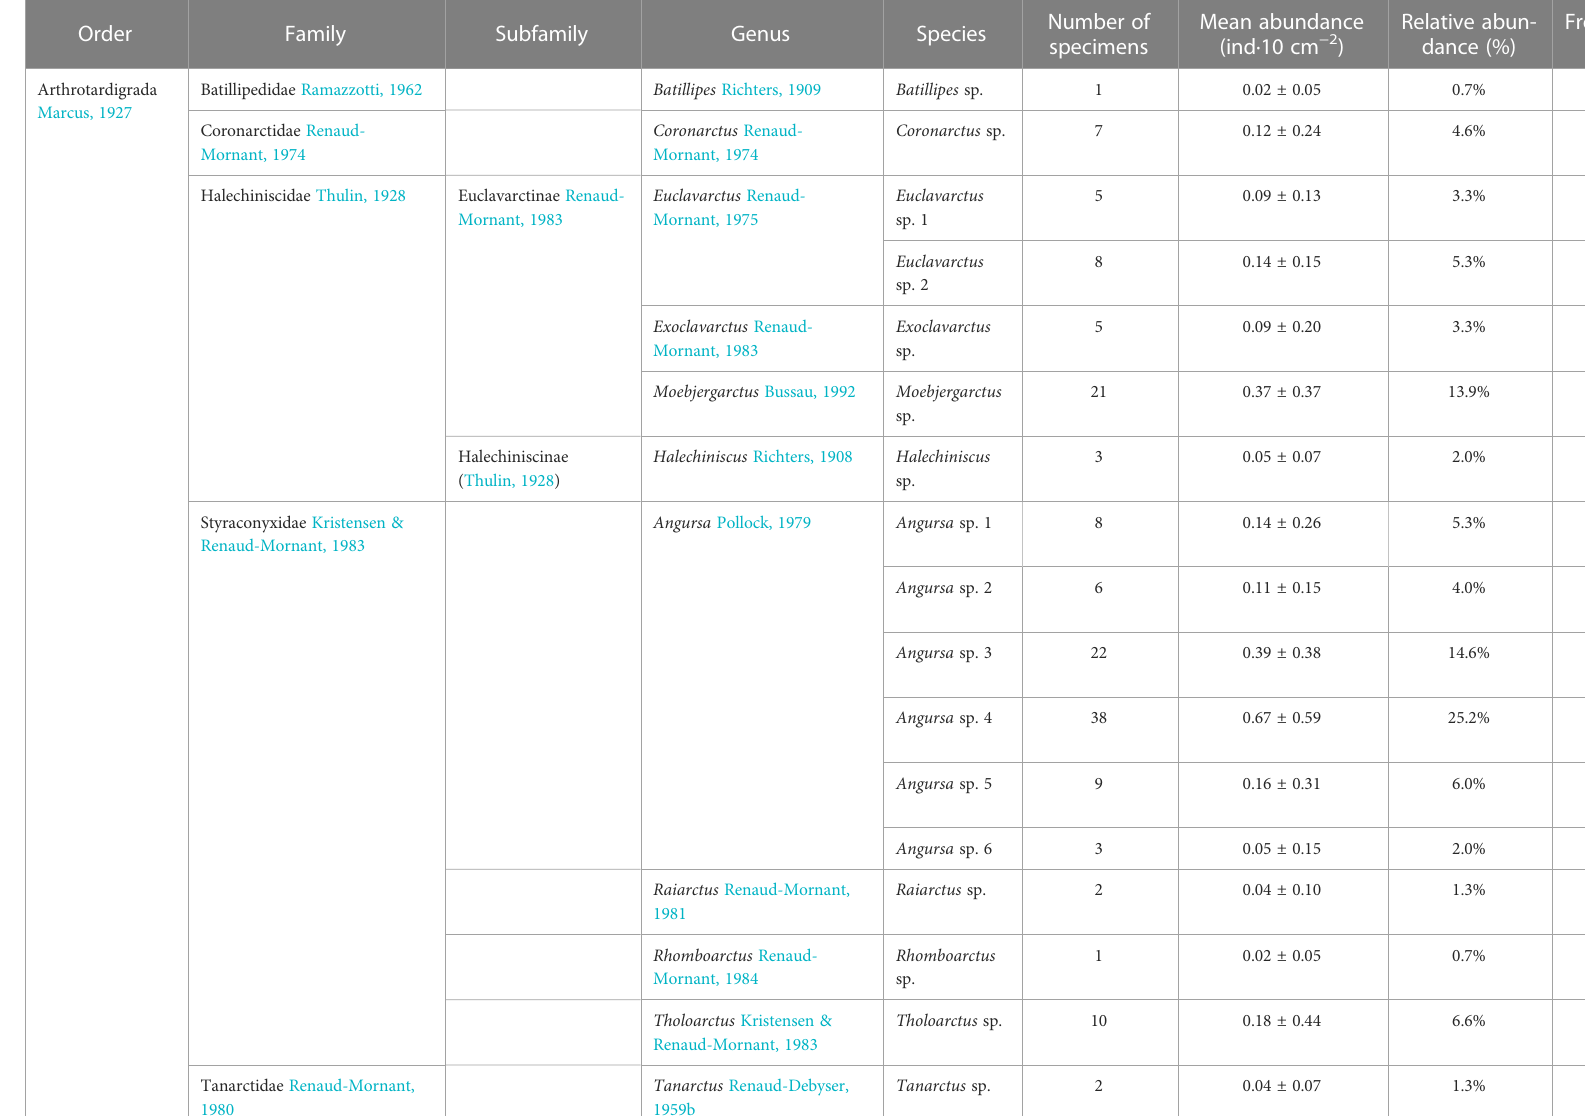
TABLE 1 Marine tardigrades collected from the deep South China Sea. Order Family Subfamily Genus Species